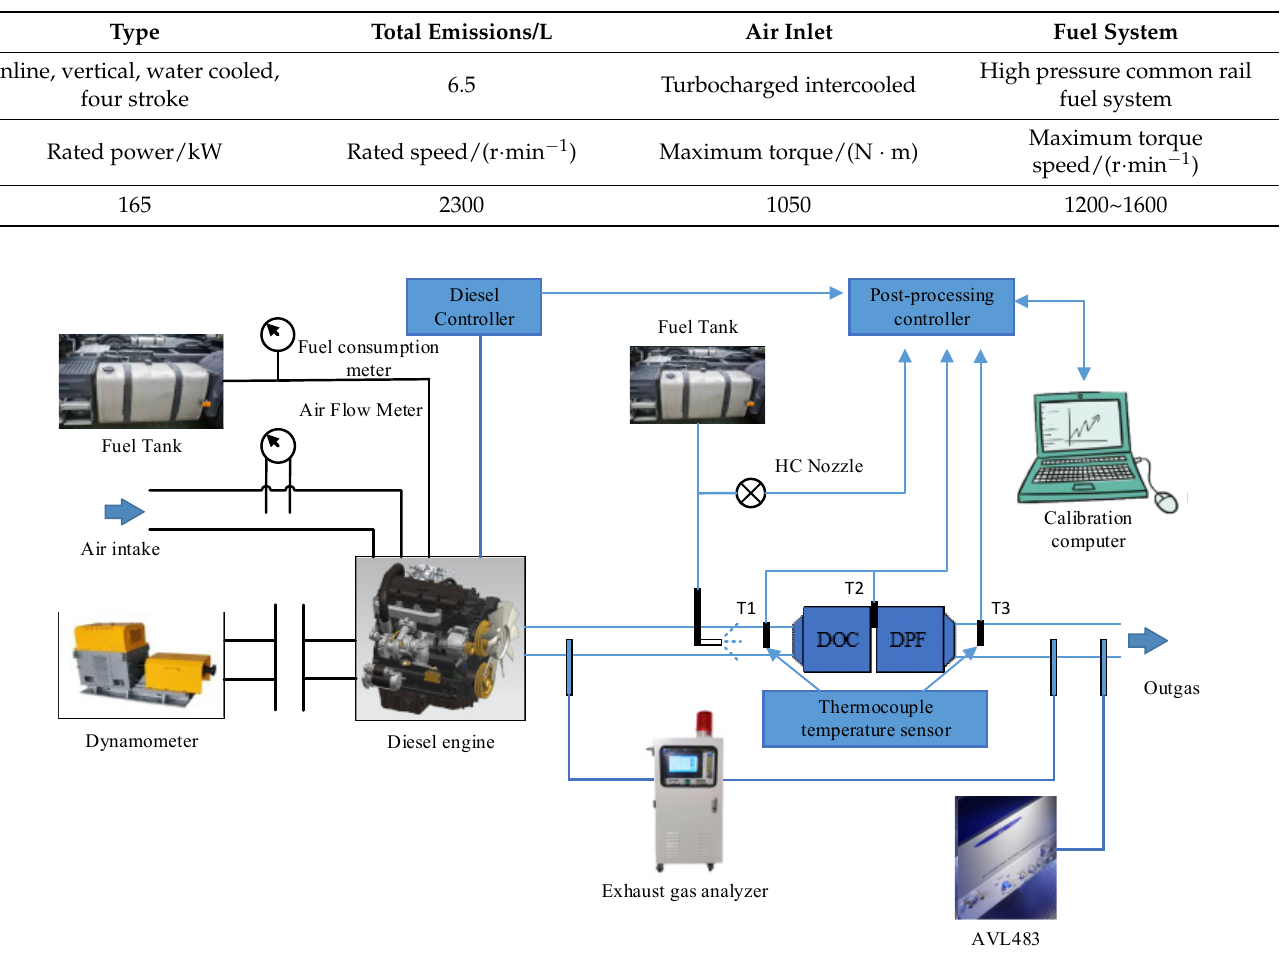
Table 1. Primary performance parameters of the test diesel engine.